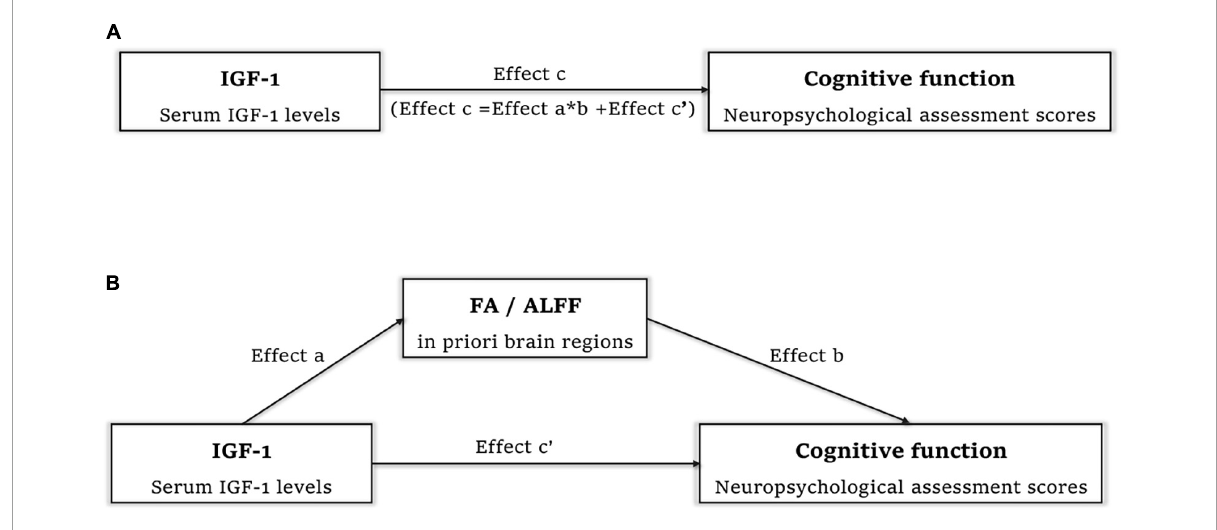
FIGURE5 Mediation analysis to find whether FA/ALFF serve as a mediate between IGF-1 and cognitive function. (A) Effect c refer to total effect of IGF-1 on cognitive function. (B) Effect c’ refer to direct effect of IGF-1 on cognitive function. Effect a refer to effect of IGF-1 on FA in right corticospinal tract and superior longitudinal fasciculus/ALFF in both precentral gyrus, postcentral gyrus and paracentral lobe. Effect b refer to effect of FA/ALFF in above regions on cognitive function. Effect a*b refer to the effect of IGF-1 on cognitive function mediated by FA/ALFF in above regions. IGF-1, insulin-like growth factor-1; FA, fractional anisotropy; ALFF, amplitude of low frequency fluctuation.